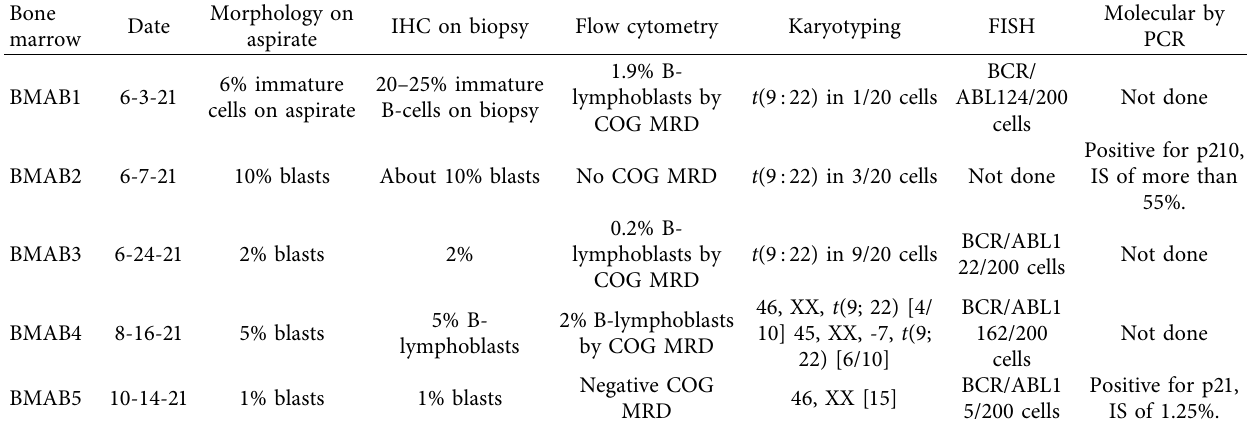
Table 1: The bone marrow aspirate and biopsy findings during the disease course. Bone